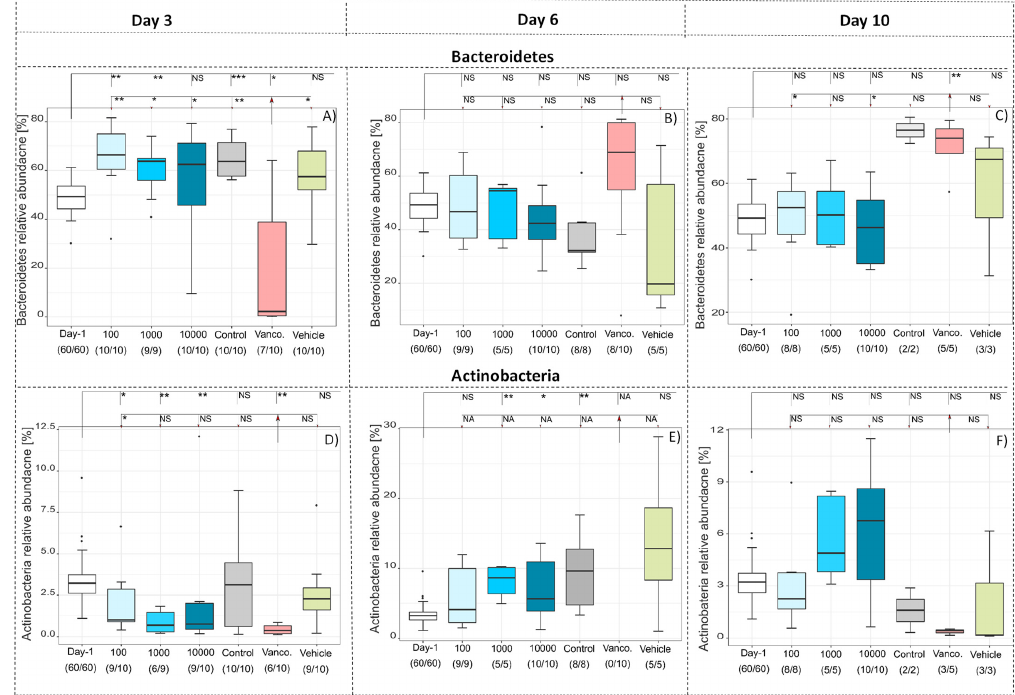
Figure 3. Relative abundance at phylum level of Bacteroidetes ( A – C ) and Actinobacteria ( A – E ) after 3 ( A , D ), 6 ( B , E ) and 10 ( C , F ) days at indicated treatment compared to the relative abundance before treatment (day -1). Significance compared to before treatment and Vancomycin values are p < 0.05 = *, p < 0.01 = **, p < 0.001 = ***, NS = not significant. Significant differences between the groups are marked by small letters.